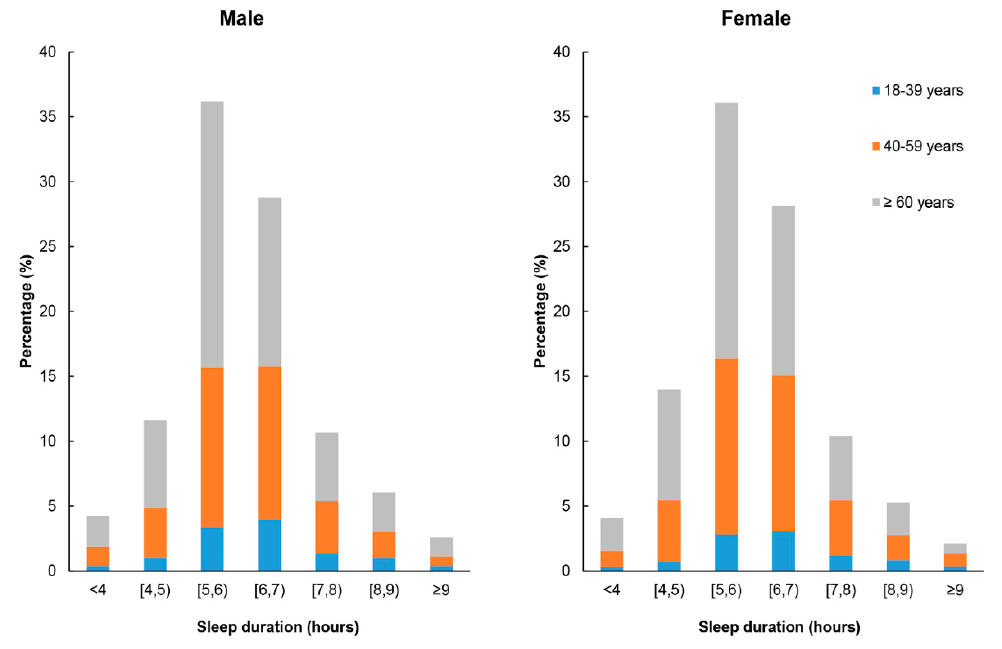
Figure 1. Distribution of sleep duration by age and sex. [4, 5): ≥ 4 and <5; [5, 6): ≥ 5 and <6; [6, 7): ≥ 6 and <7; and [7, 8): ≥ 7 and <8.